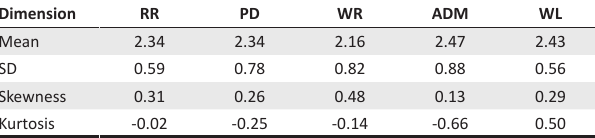
TABLE 5: Descriptive statistics of employee morale dimensions ( N = 167). Dimension